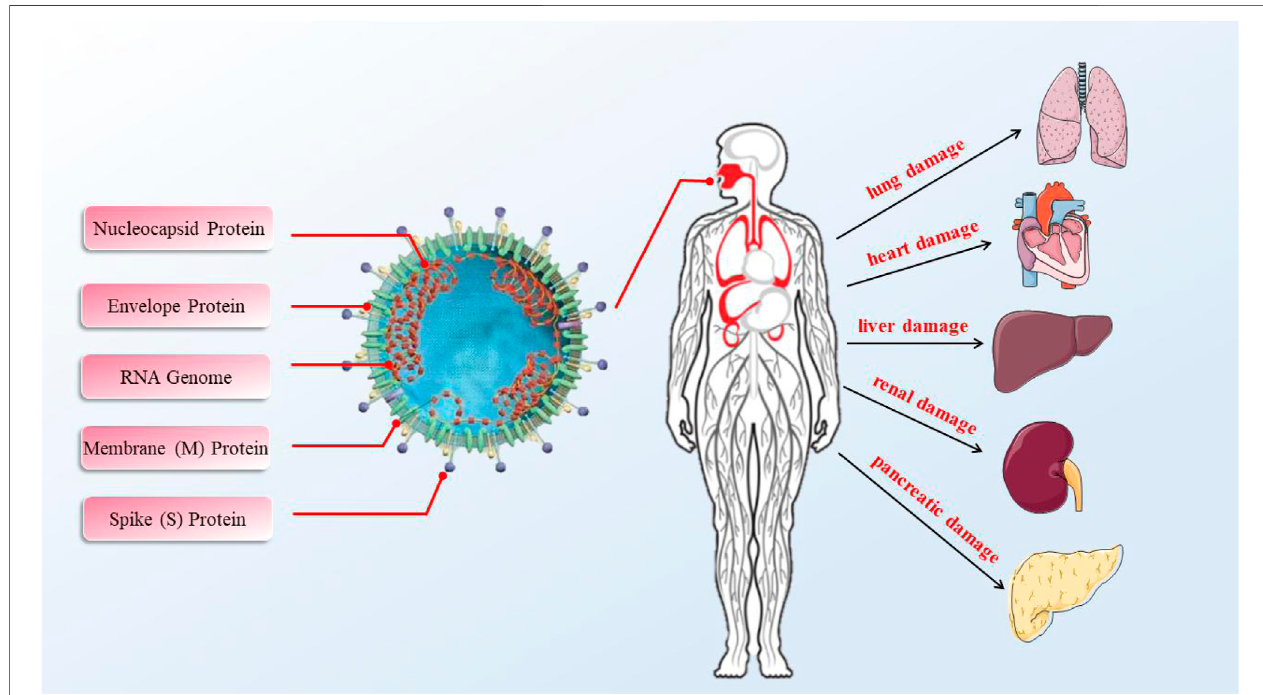
FIGURE 1 | The virus structure of SARS-CoV-2 and its organ damage. It was found that in the 52 COVID-19 patients, the incidence of heart injury was 33% (abnormalLDHorcreatinekinase),liverinjurywas29%(anyabnormalityinAST,ALT,GGT,orALP),pancreaticinjurywas17%,renalinjurywas8%(abnormalcreatinine), and diarrhea was